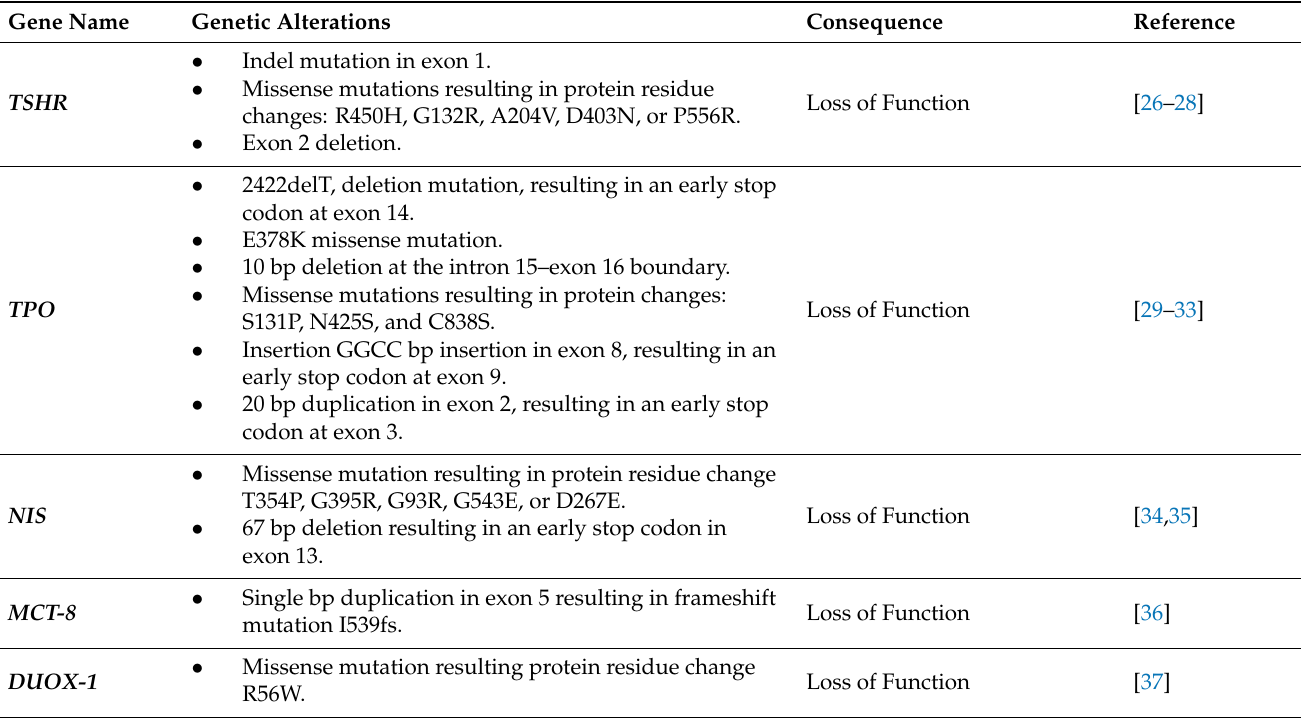
Table 3. Genetic changes in human hypothyroidism consistent with altered gene expression in CKO